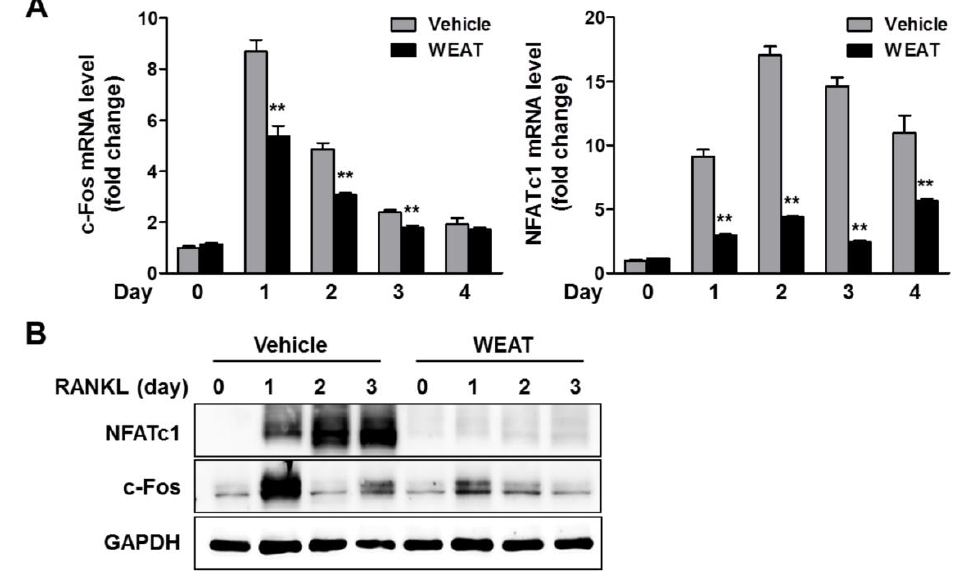
Figure 2. Effect of WEAT on RANKL-induced c-Fos and NFATc1 expression in BMMs. BMMs were cultured with vehicle or WEAT (50 μg/mL) in the presence of M-CSF (60 ng/mL) and RANKL (100 ng/mL) for the indicated days. ( A ) mRNA expression levels of c-Fos and NFATc1 were determined by real-time quantitative polymerase chain reaction (qPCR). ** p < 0.01 versus vehicle-treated control. ( B ) Protein expression levels of c-Fos and NFATc1 were determined by western blot analysis. Total GAPDH was used as a loading